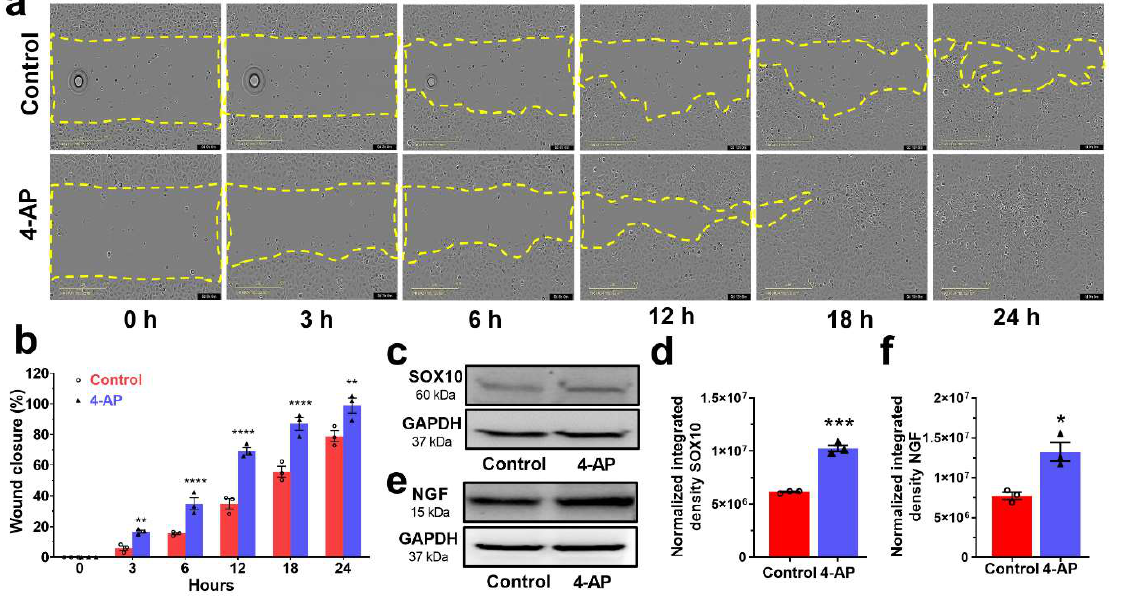
Figure 7. 4-AP accelerates in vitro keratinocyte wound closure. ( a ) Representative images of in-vitro keratinocyte scratch assays with 4-AP and vehicle control at indicated time points. The yellow lines indicate the wound borders at the beginning of the assay and were recorded every hour until 24 h. Scale bar =100 µ m. ( b ) The relative percentage of wound closure was calculated as the ratio of the remaining wound gap at the given time point compared to time 0. Each image represents 9 images from 3 biological replicates and data represented as mean ± SEM, n = 3 biological replicates per group, statistical significance indicated by asterisks (O = saline mouse data points, ∆ = 4-AP treated mouse data points, ** = p between 0.01 and 0.001, and **** = p between 0.0002 and 0.0001 vs. control). ( c – f ) A representative Western blot and normalized integrated densities for SOX10 and NGF. Mean ± SEM, n = 3 biological replicates per group, statistical significance indicated by asterisks (O = saline mouse data, ∆ = 4-AP treated mouse data, * = p between 0.01 and 0.05, and *** = p between 0.001 and 0.0002 vs. control).